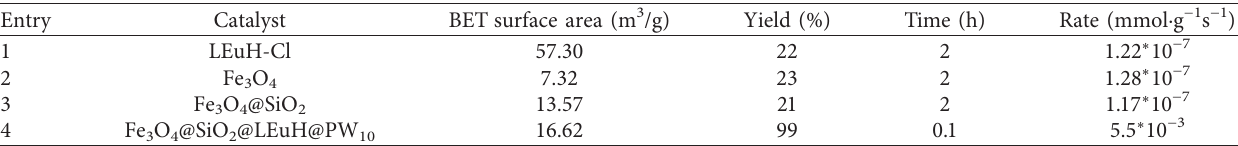
3 O 4 , Fe 3 O 4 @SiO 2 , and Fe 3 O 4 @SiO 2 @PW 10 catalysts.